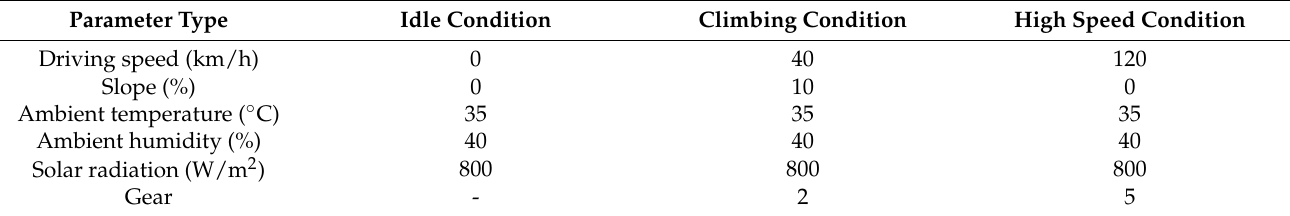
Table 3. Parameter requirements of the vehicle heat balance working